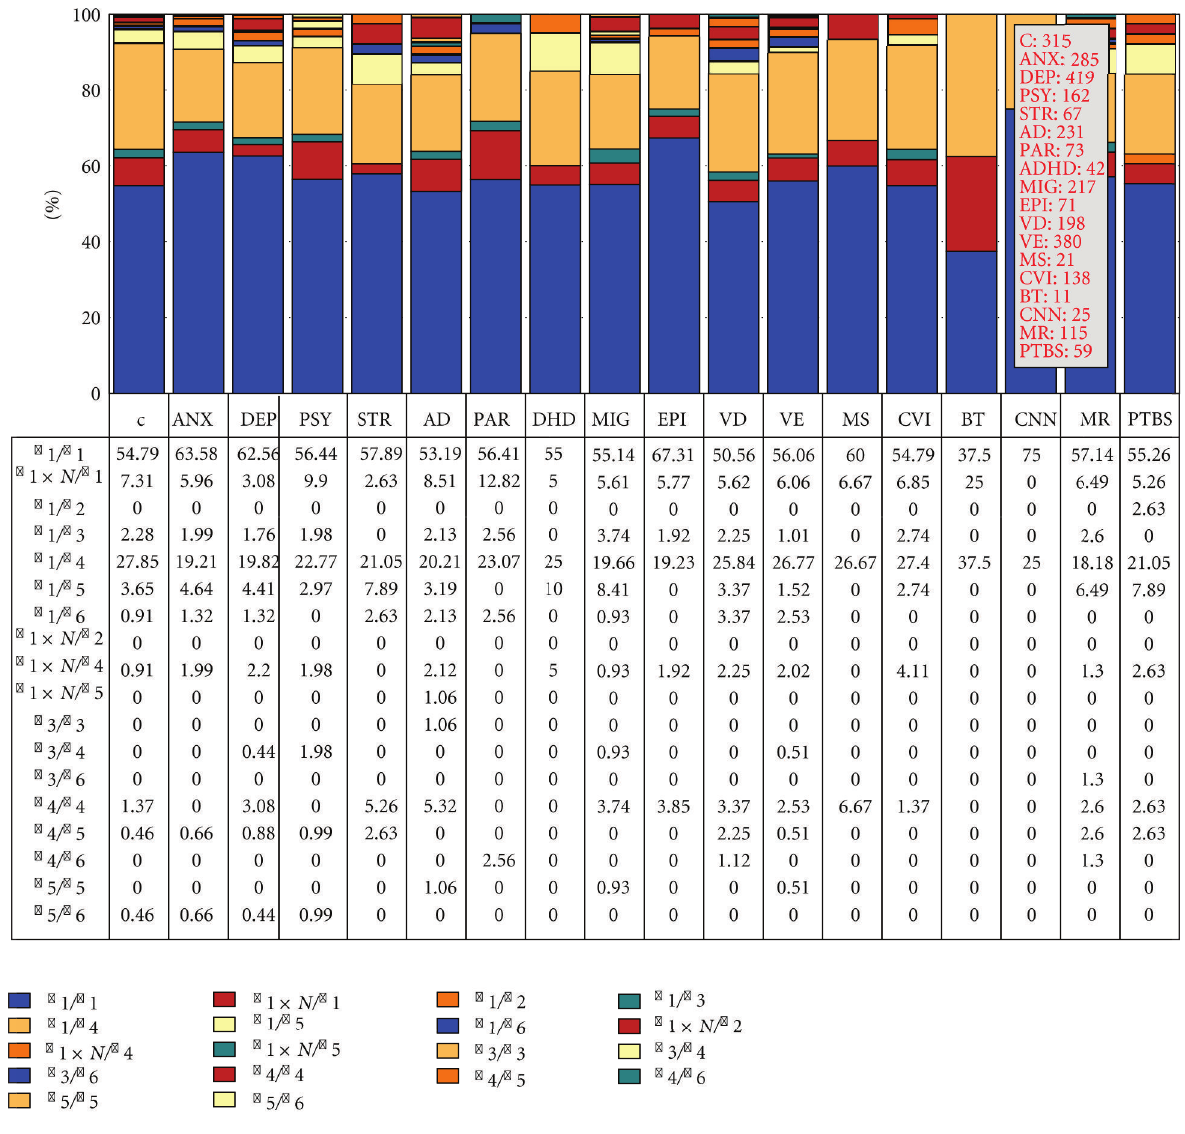
Figure 6: Distribution and frequency of CYP2D6 variants in patients with CNS disorders. C: controls; ANX: anxiety; DEP: depression; PSY: psychotic disorders; STR: stroke; AD: Alzheimer’s disease; PAR: Parkinson’s disease; ADHD: attention-deficit hyperactivity disorder; MIG: migraine; EPI: epilepsy; VD: vascular dementia; VE: vascular encephalopathy; MS: multiple sclerosis; CVI: cerebrovascular insu ffi ciency; BT: brain tumors; CNN: cranial nerve neuropathies; MR: mental retardation; PTBS: posttraumatic brain injury syndrome. Source: R. Cacabelos. CIBE Database. EuroEspes Biomedical Research Center, Institute for CNS Disorders, Coru˜na,